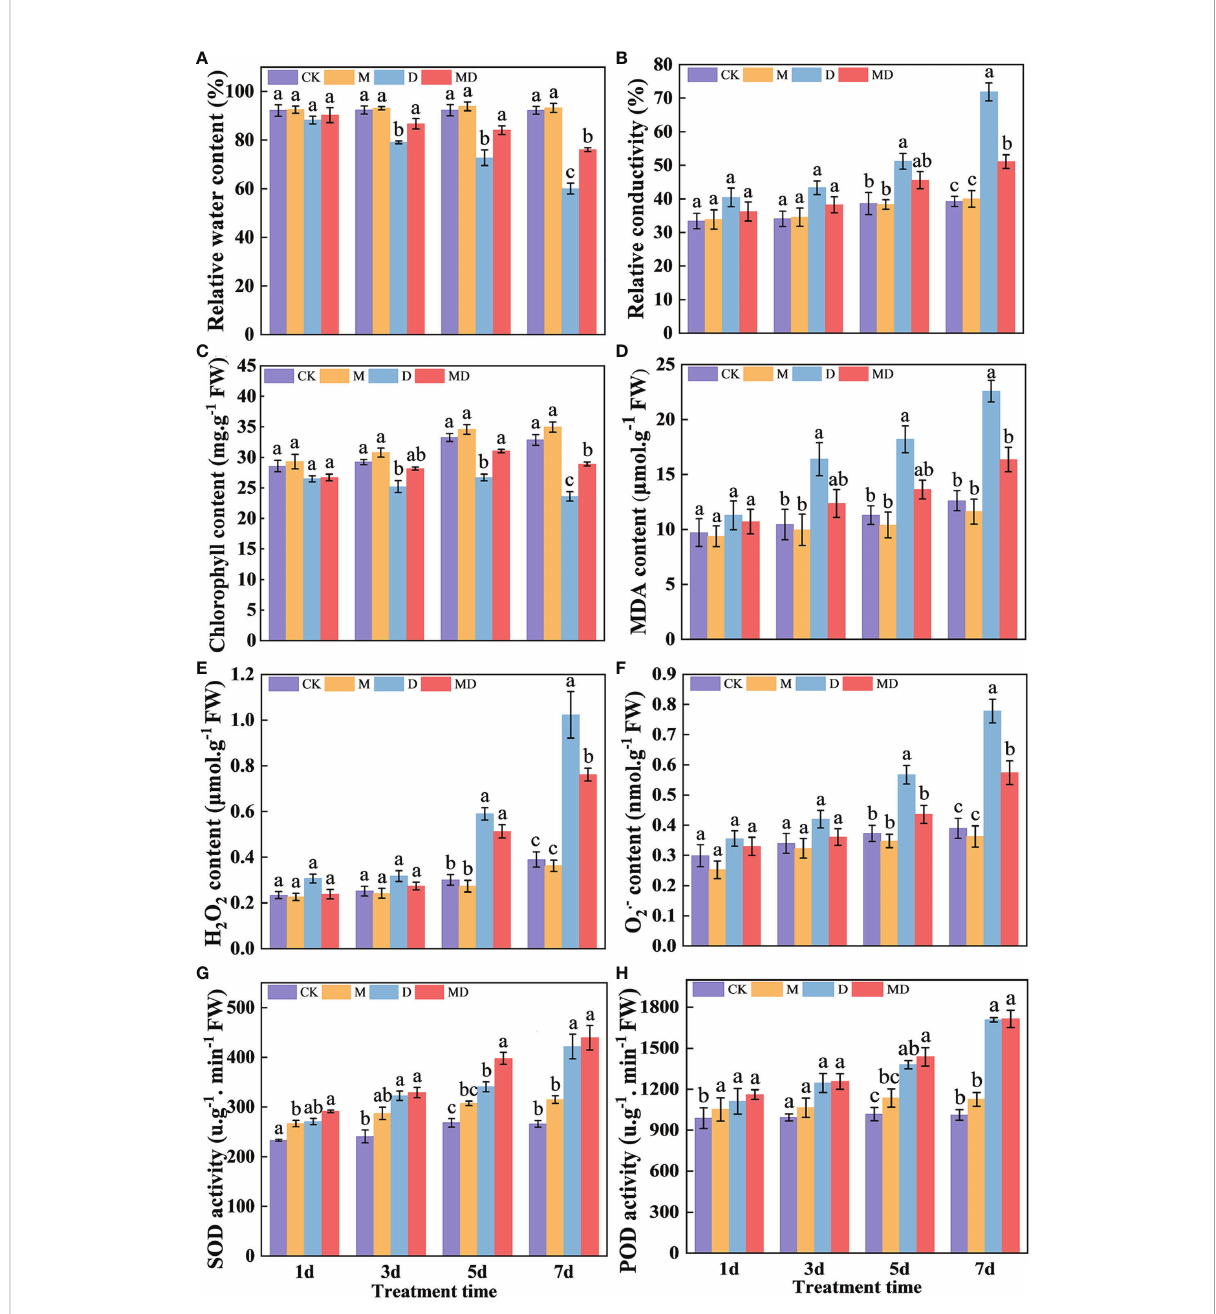
FIGURE 2 Effects of 100 mg·L − 1 MT on the physiology of A. mongolicum seedlings under different durations of drought stress. (A) Relative water content, (B) relative conductivity, (C) chlorophyll content, (D) MDA content, (E) H 2 O 2 content, (F) O 2 − content, (G) SOD activity, (H) POD activity. Mean values followed by different letters were signi fi cantly different by Duncan ’ s test ( P <